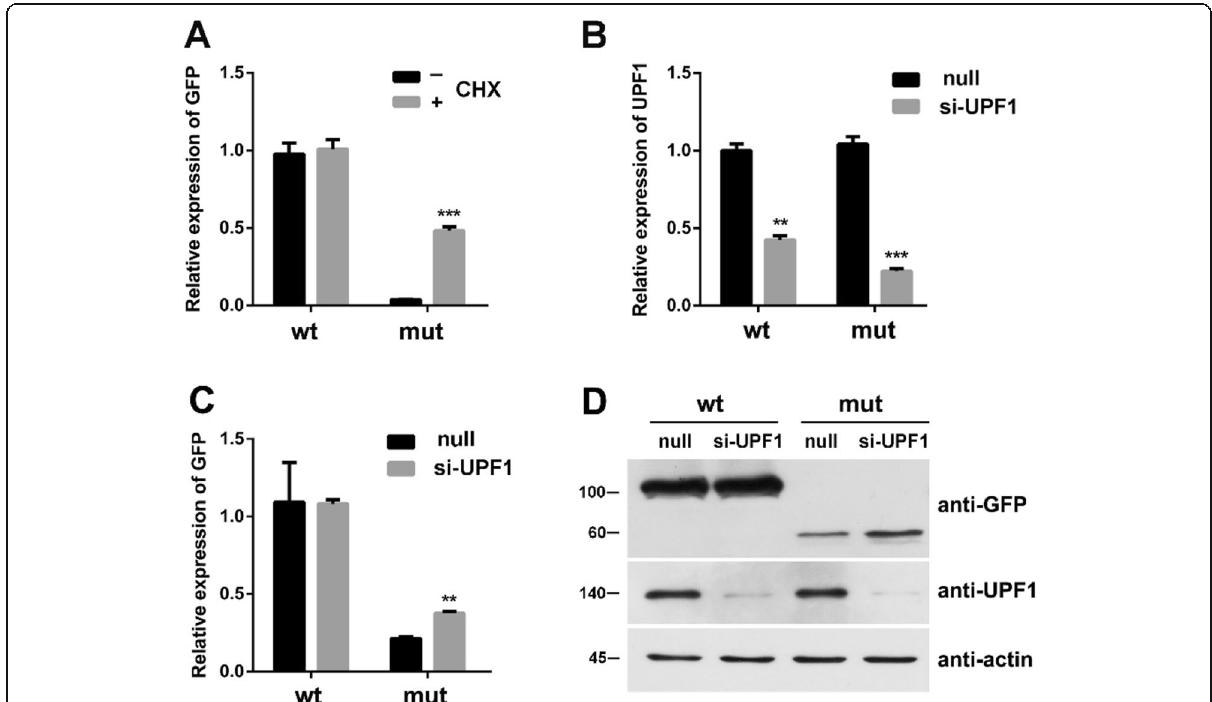
Fig. 5 Effects of the suppression of NMD by CHX and UPF1 siRNA (si-UPF1). A , 293 T cells were transfected with WT and mutant plasmids and were sequentially added into CHX to inhibit translation for 8 h. The relative expression of EGFP-F13A1 was verified via qPCR. B , the expression of UPF1 was analyzed using transfected cells by si-UPF1. C, D , 293 T cells expressing the WT and mutant F13A1 were transfected with UPF1 siRNA for 48 h. EGFP-F13A1 mRNA and protein expression were quantified via qPCR and western blot. ** p < 0.05, *** p <